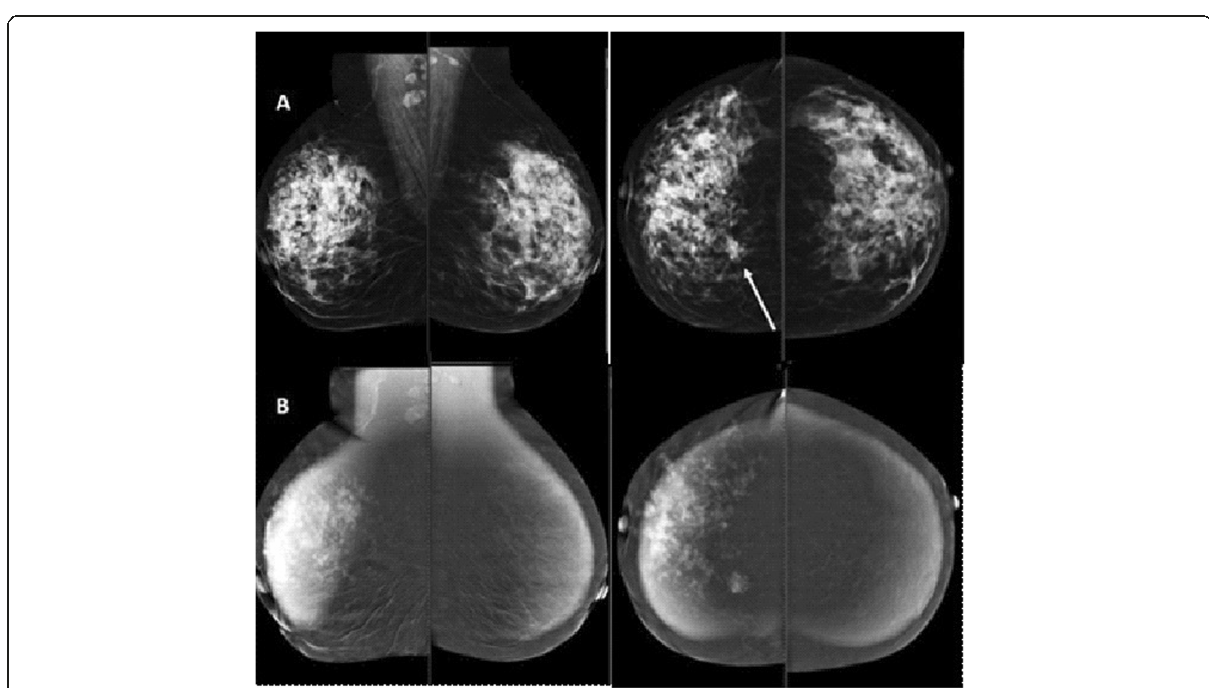
Fig. 4 Deeply seated lobular carcinoma presenting as a single view asymmetry (arrow) on the low-energy images in a heterogeneous dense